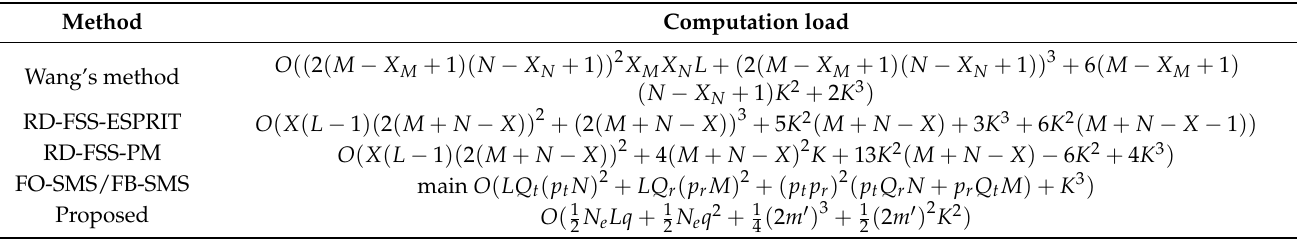
Table 1. Comparison of the complexity.